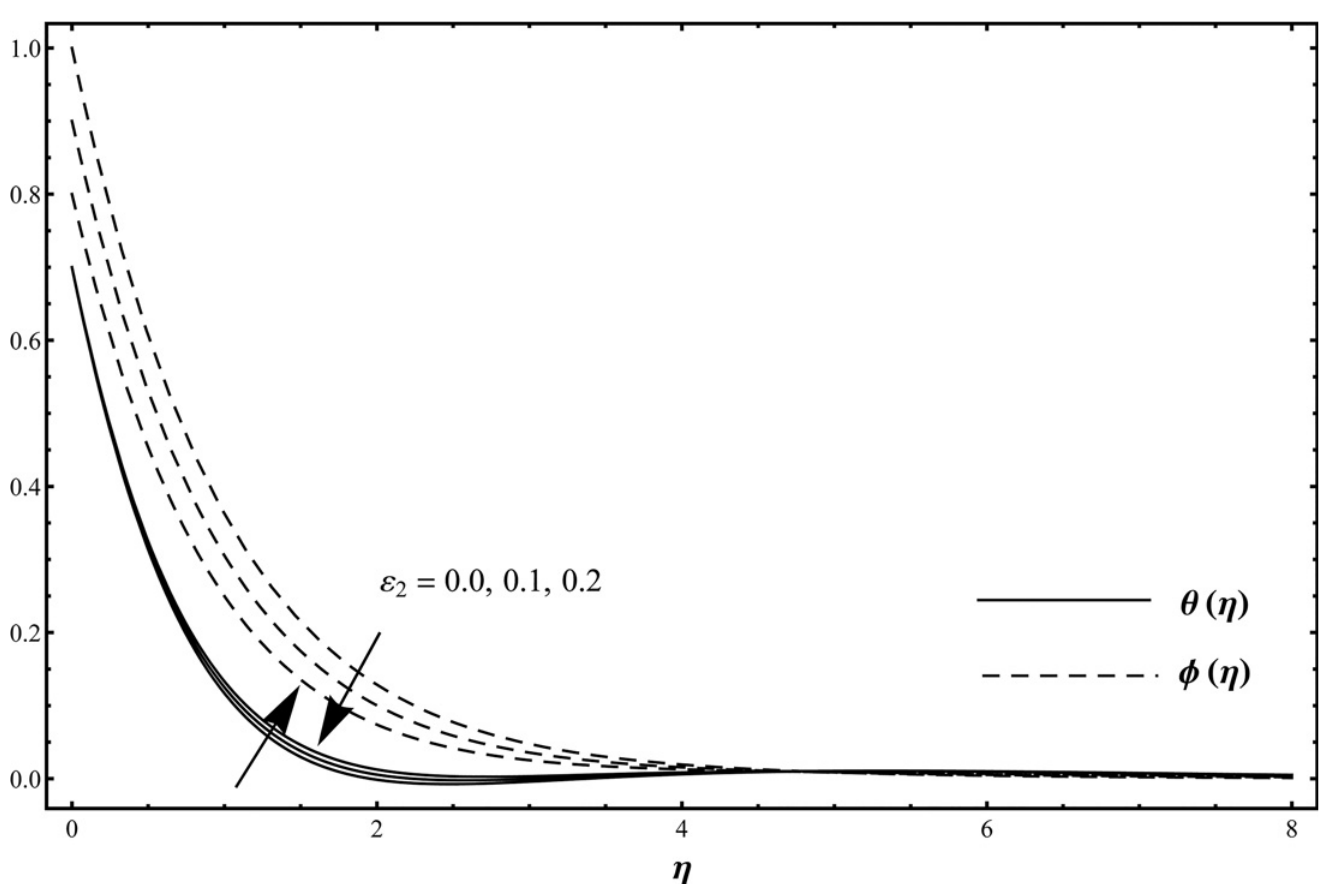
Fig 5. Temperature distribution function θ ( η ) and concentration distribution function ϕ ( η ) when ε 2 = 0.0, 0.1, 0.2 and β 1 = β 2 = 0.2 = γ = Rd , λ = 0.1 = N , Pr = 1.0 = Sc and ε 1 =